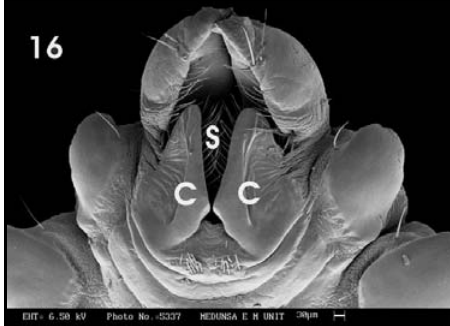
Fig. 14. Dorsal view of the female abdomen.